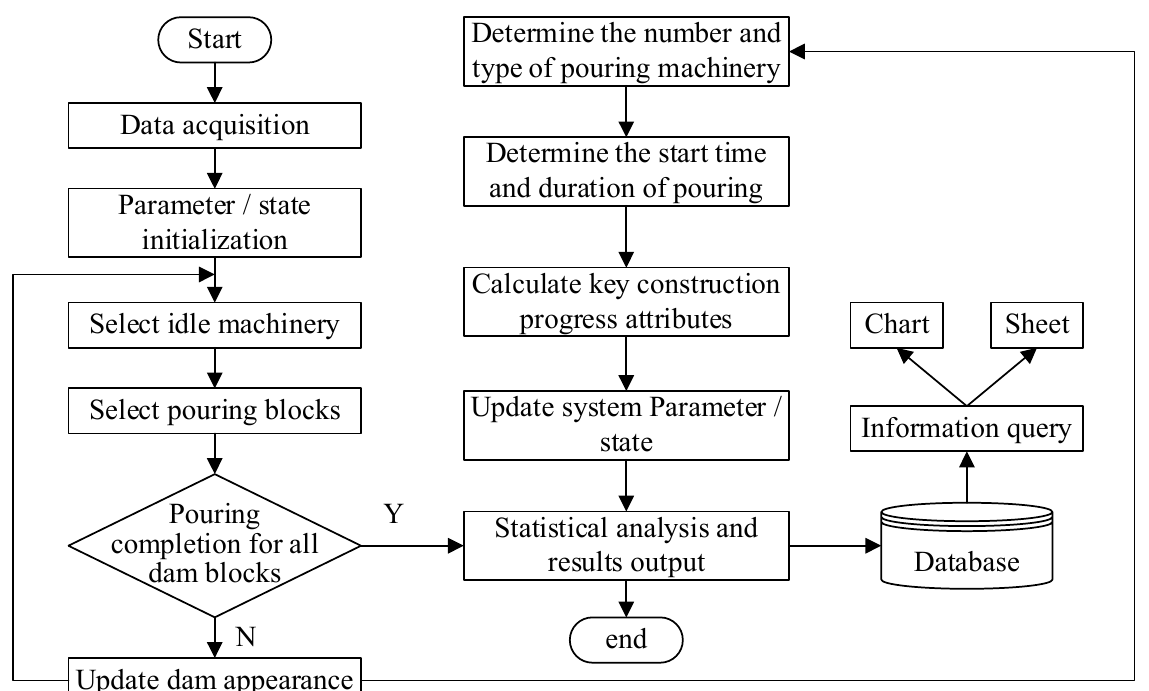
Figure 2. Flowchart of construction simulation for concrete dams.